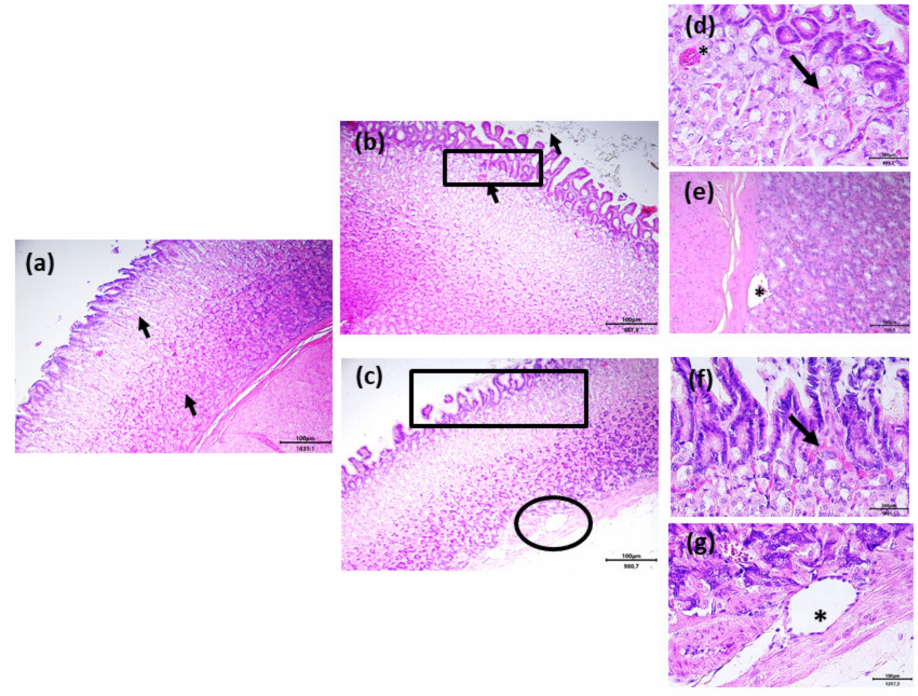
Figure 7. HE haematoxylin/eosin staining. The fundic mucosa of the stomach is regularly organized in control ( a ), group supplemented with flaxseed ( b ), and with fish oil ( c ). Blood cell infiltrates (( d ) for group supplemented with flaxseed and ( f) for group supplemented with fish oil) as well as enlarged vessels (( e ) for group supplemented with flaxseed and ( g ) for group supplemented with fish oil) were present in treated animals. Proper scale bar is located in each figure. For the interpretation of the arrow and the asterisk, see the